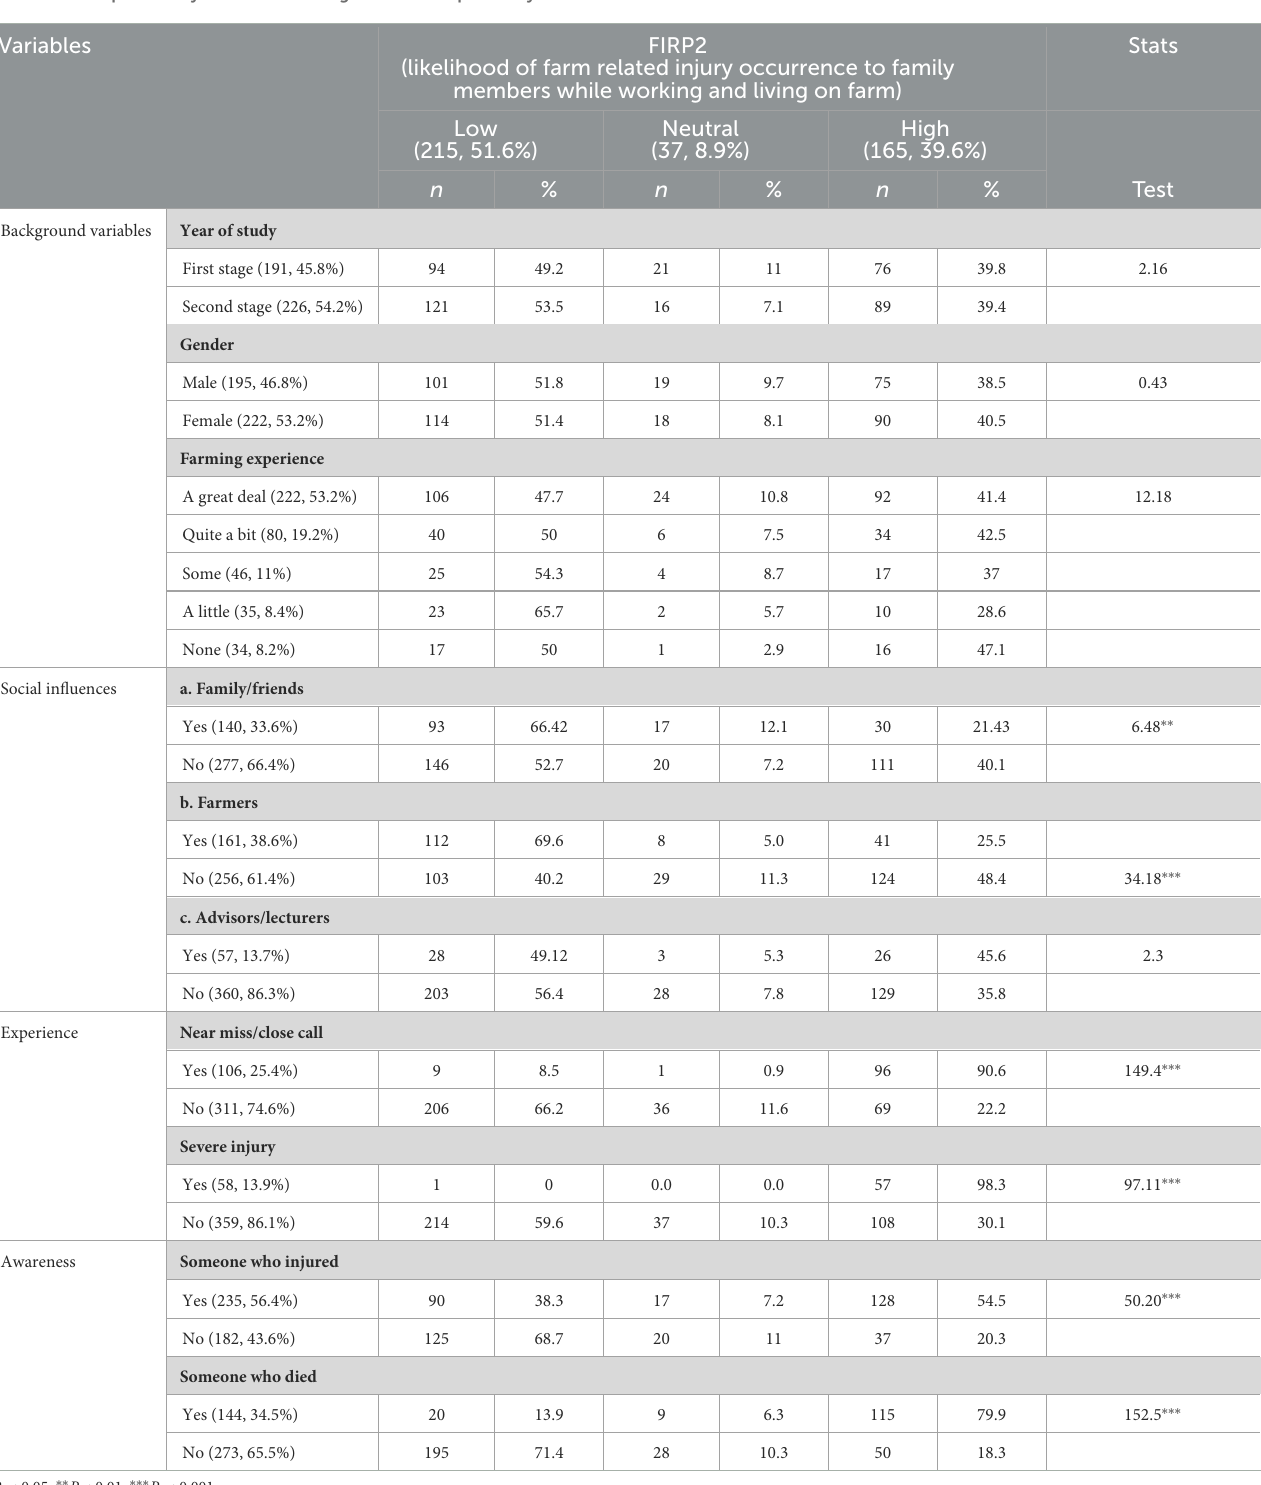
TABLE 2 Chi-square analysis between background and explanatory variables and FIRP2. Variables FIRP2